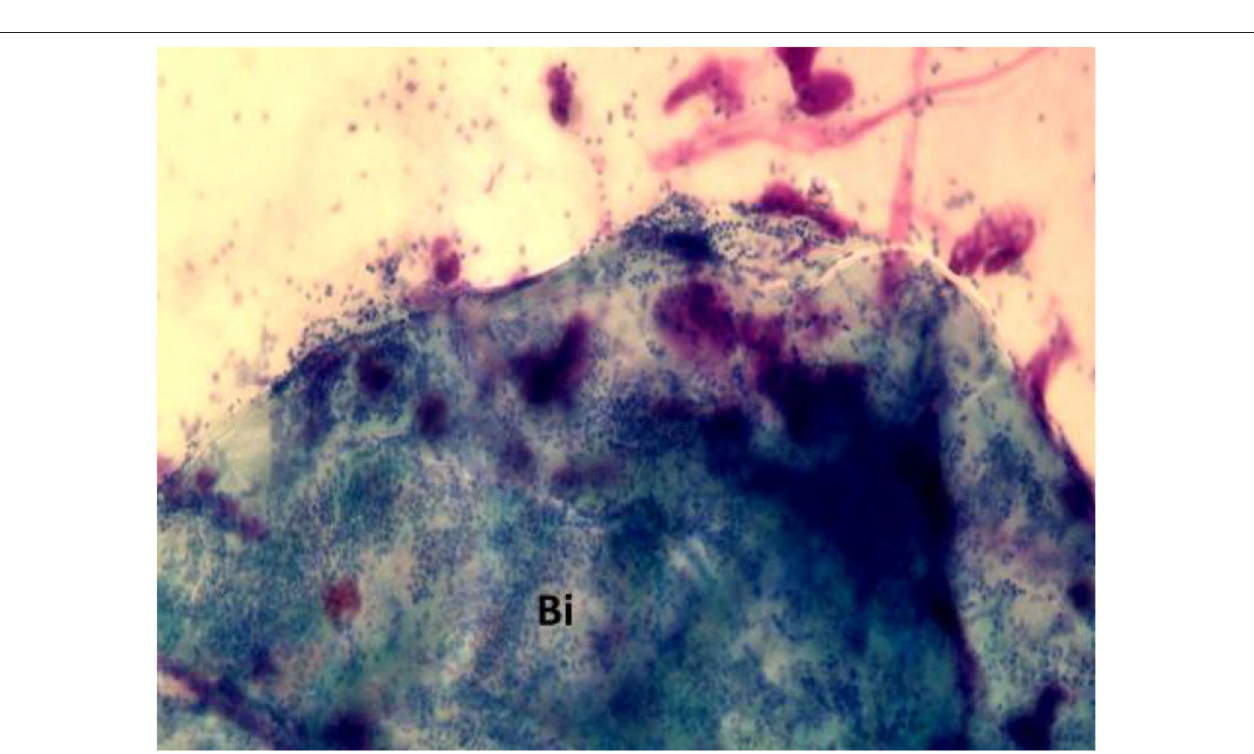
FIGURE 5 | Nasal cytology in a patient with CRSwNP, showing “cyan” spots. Bi, biofilm. MGG staining. Magnification 1000x.